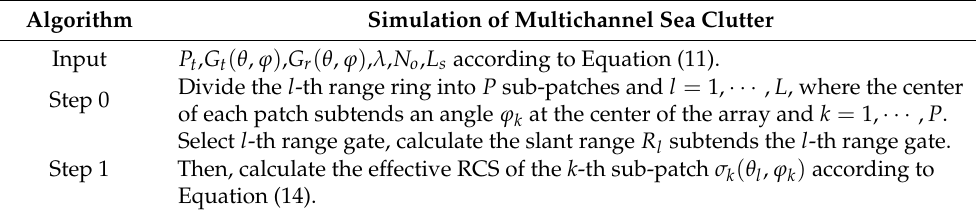
Table 2. The specific steps of multichannel sea clutter